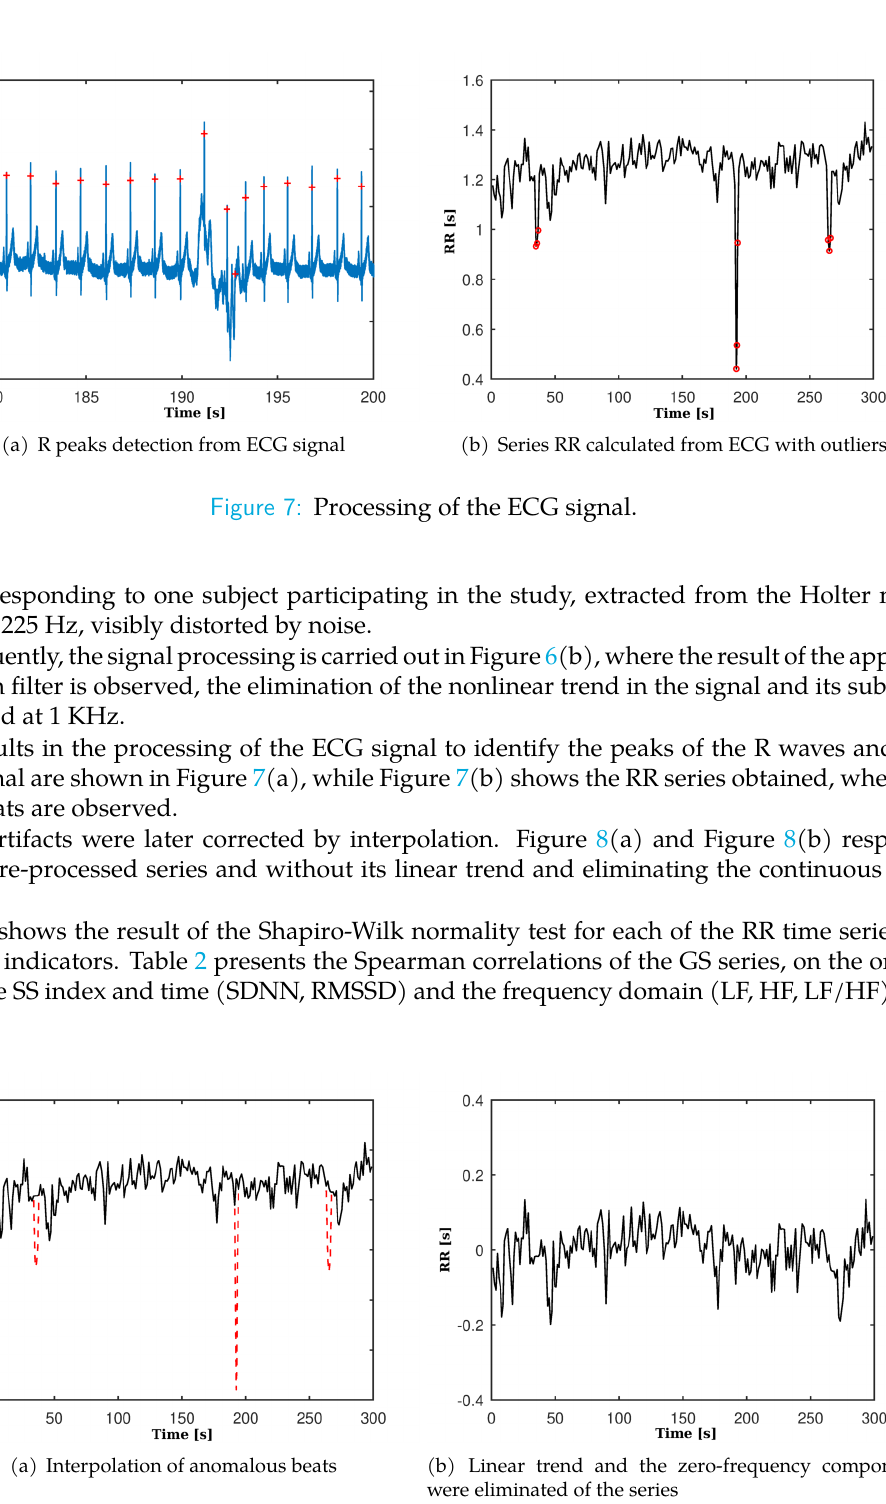
Figure 8: Interpolation of the ECG